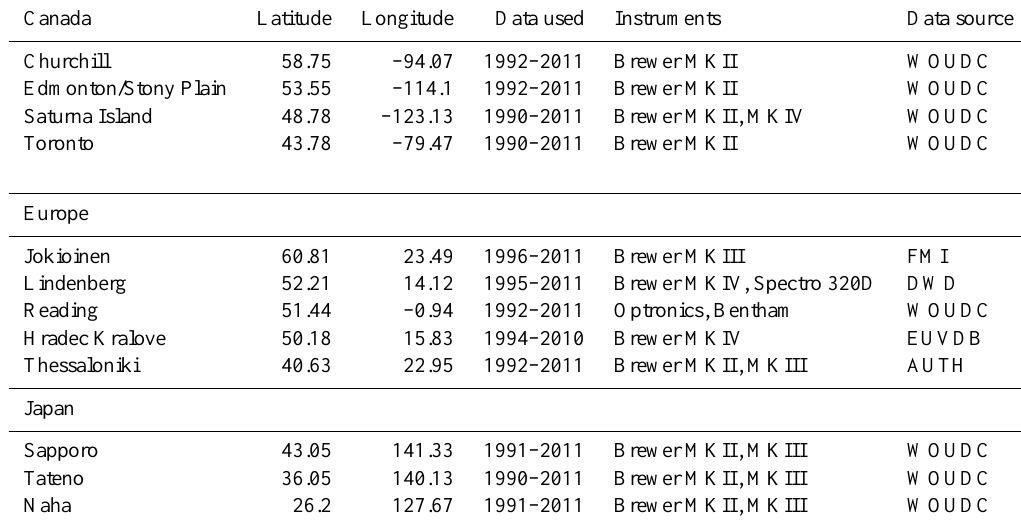
Table 1. Mid-latitude stations with long series of accessible spectral UV data analysed in this study.